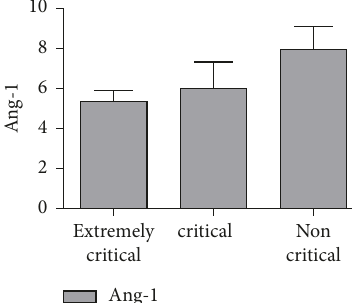
Figure 2: Comparison of serum Ang-1 levels in children with different severity of RDS.